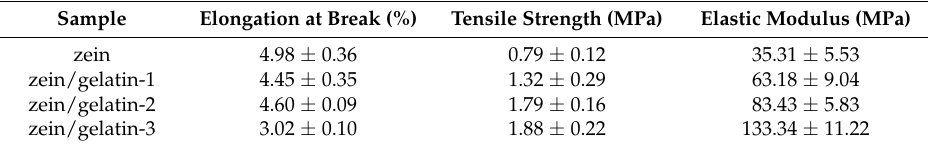
Table 1. Mechanical properties of electrospun zein/gelatin nanofibers with different compositions.